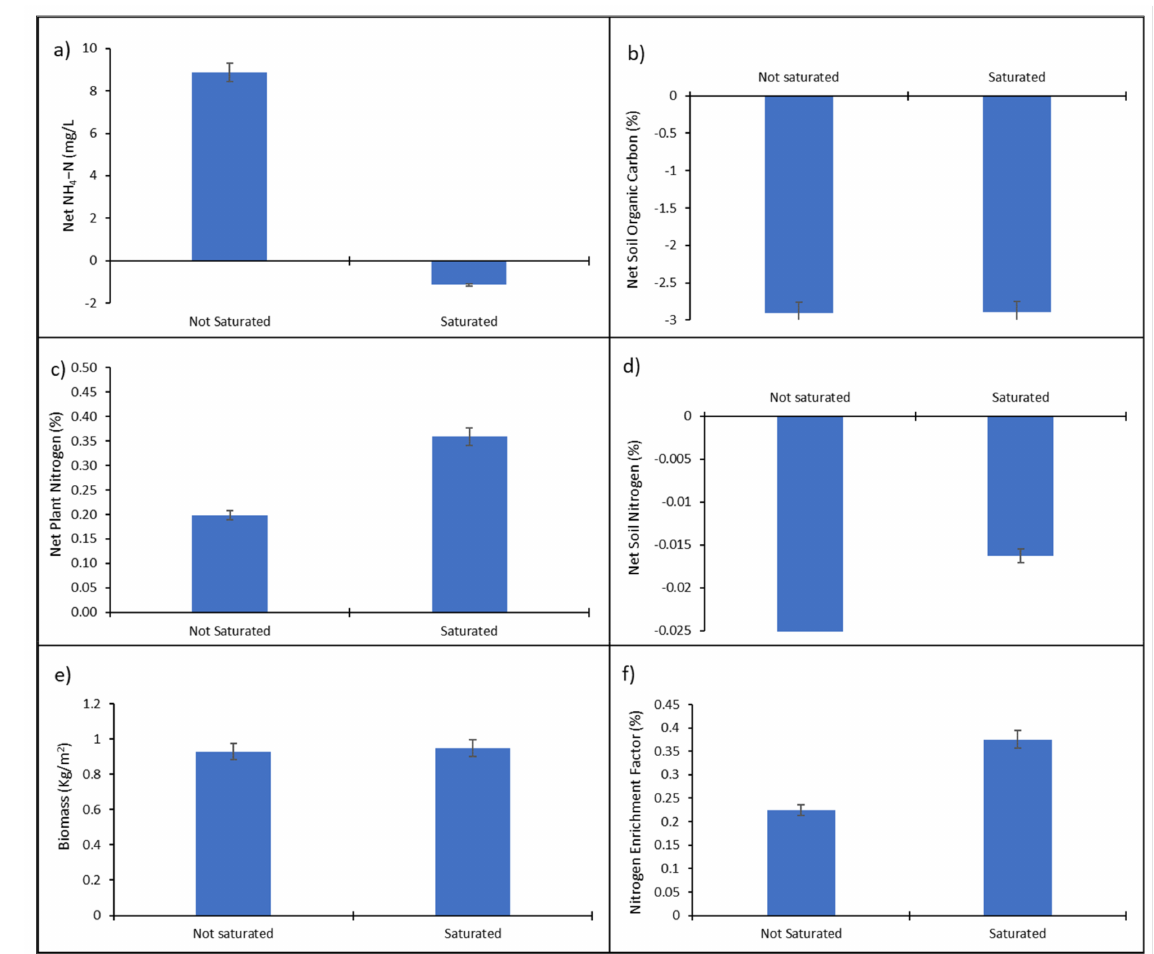
Figure 4. Mean differences in additional site factors for saturated vs. not saturated grassland plots across the growing stages, where ( a ) represents net ammonium concentrations (NH 4 + − N), ( b ) represents changes in soil organic carbon levels, ( c ) represents net foliar nitrogen, ( d ) represents net soil nitrogen, ( e ) represents biomass yield, and ( f ) represents the nitrogen enrichment